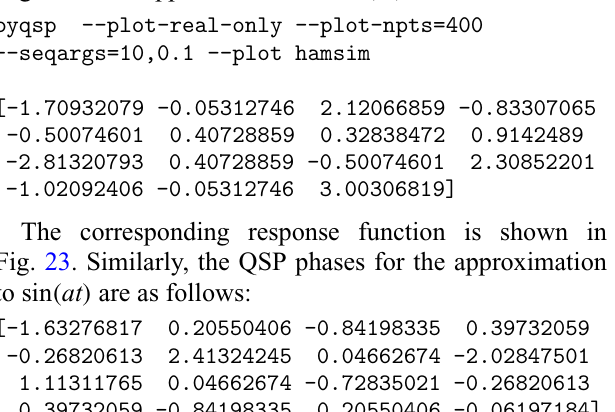
FIG. 24. The response function for the polynomial approxima- tion to the sine function with t = 5 and (cid:14) =